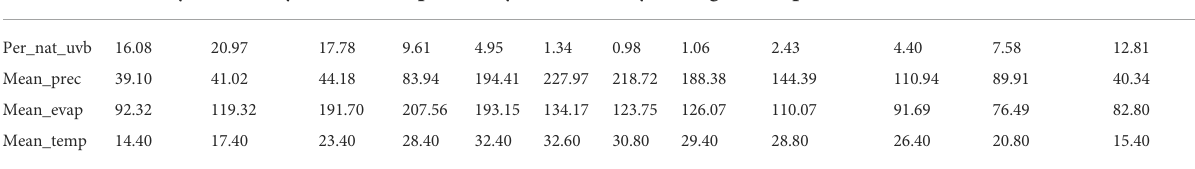
TABLE 1 Monthly dynamics of meteorological conditions in Yuanyang